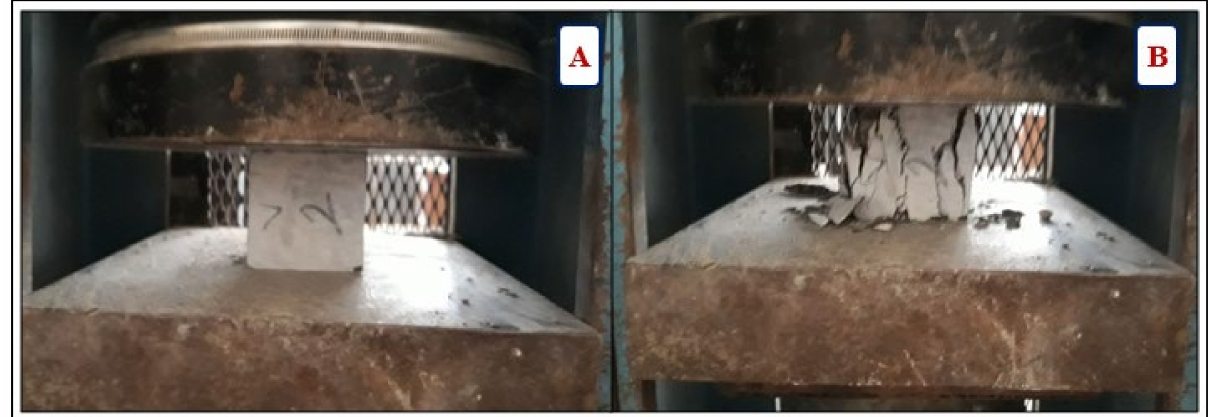
Figure 9. Compressive strength test: ( A ) test setup, ( B ) specimen failure.